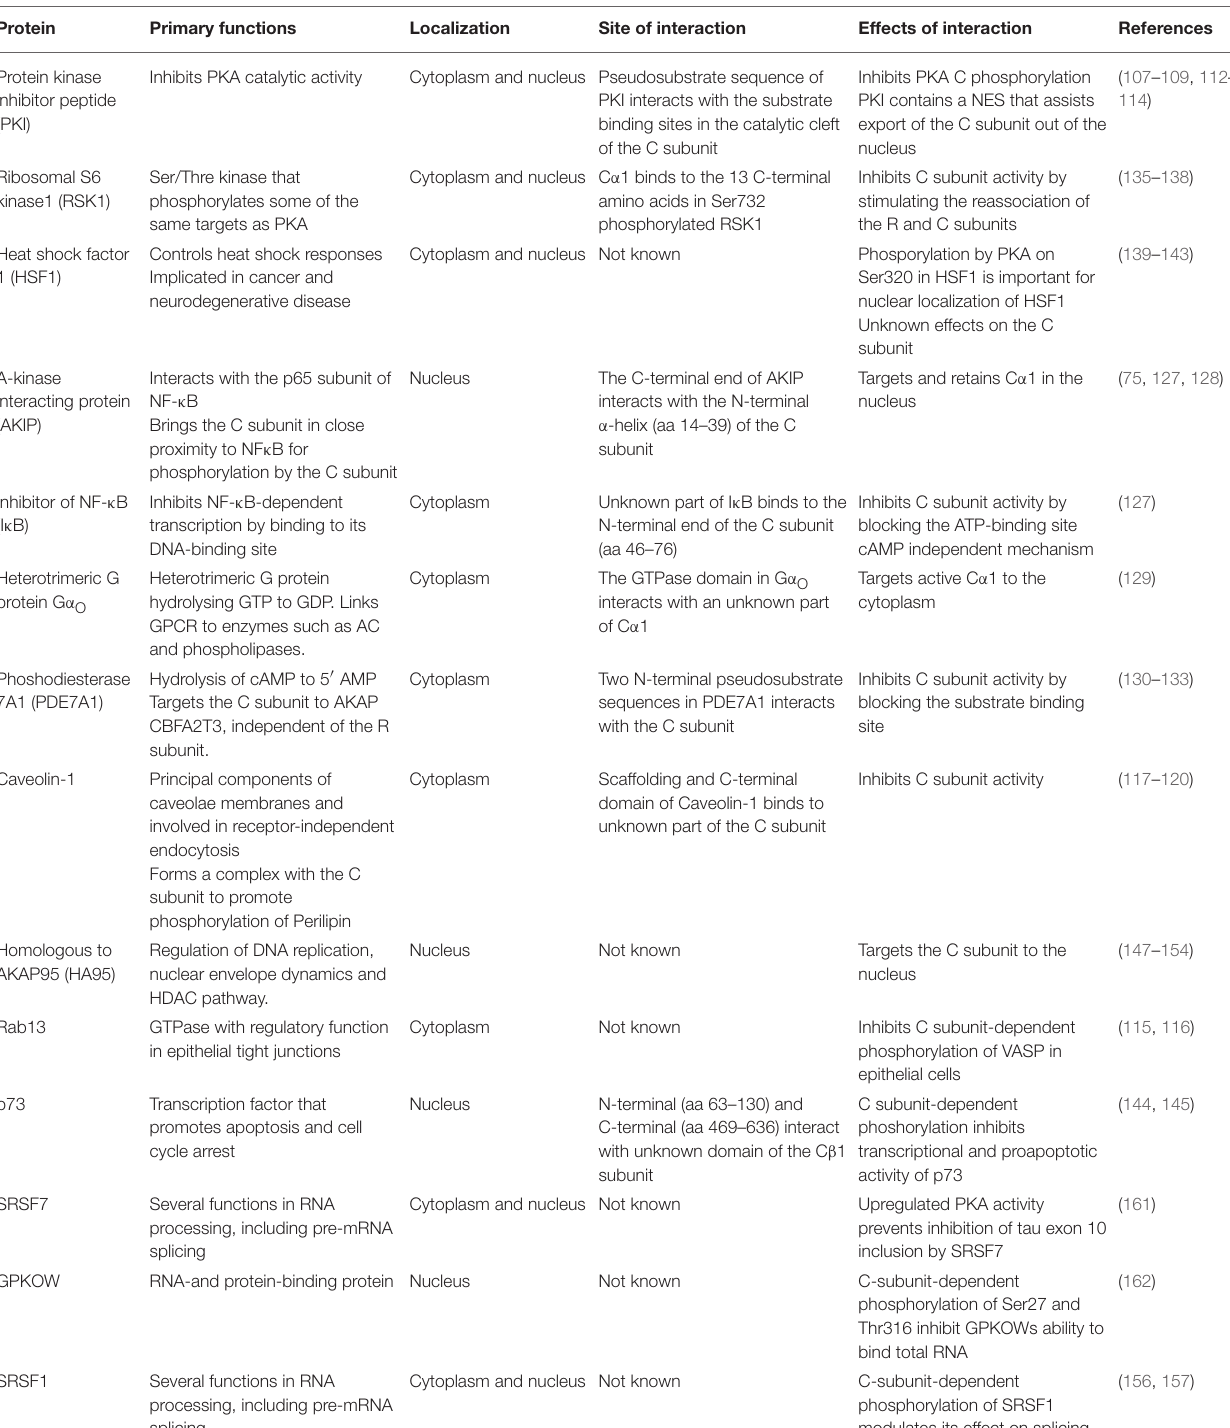
TABLE 1 | Overview of selected C kinase anchoring proteins (C-KAPs).